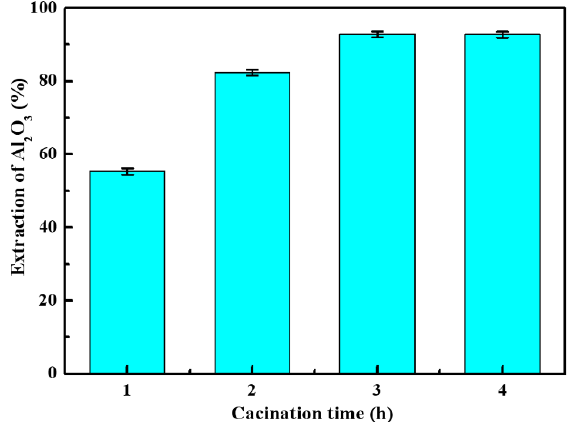
Figure 5. Effects of calcination time on alumina extraction from CFA at 230 °C and a KHSO 4 /Al 2 O 3 molar ratio of seven.